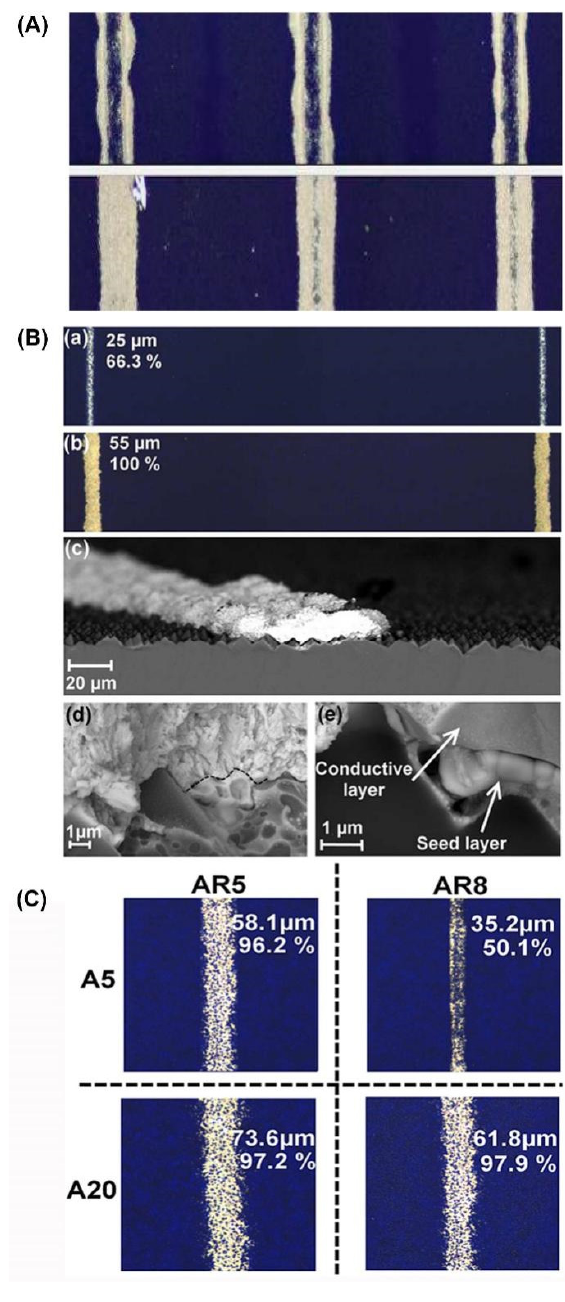
Figure 2. ( A ) Microscopic views for the comparison of three representative lines printed with paste A0 ( upper ) and ink A5 ( lower ). Reproduced with permission. Ref. [36] Copyright 2011. ( B ) Overview of the metallization results before ( a ) and after ( b – e ) the seed layer thickening by Ag-LIP. Reproduced with permission. Ref. [38] Copyright 2015. John Wiley and Sons. ( C ) Comparison of lines printed in the same conditions with different inks and anilox rolls. For each case, the line width and the line metallized area are reported. Reproduced with permission. Ref. [38] Copyright 2015. John Wiley and Sons.